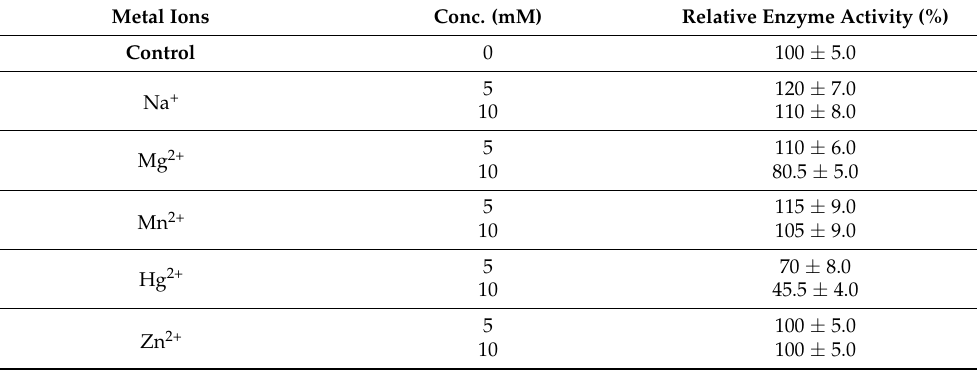
Table 3. Effect of some metal ions and inhibitors on the activity of purified chitinase on solid state fermentation by T. funiculosus strain CBS 129594.